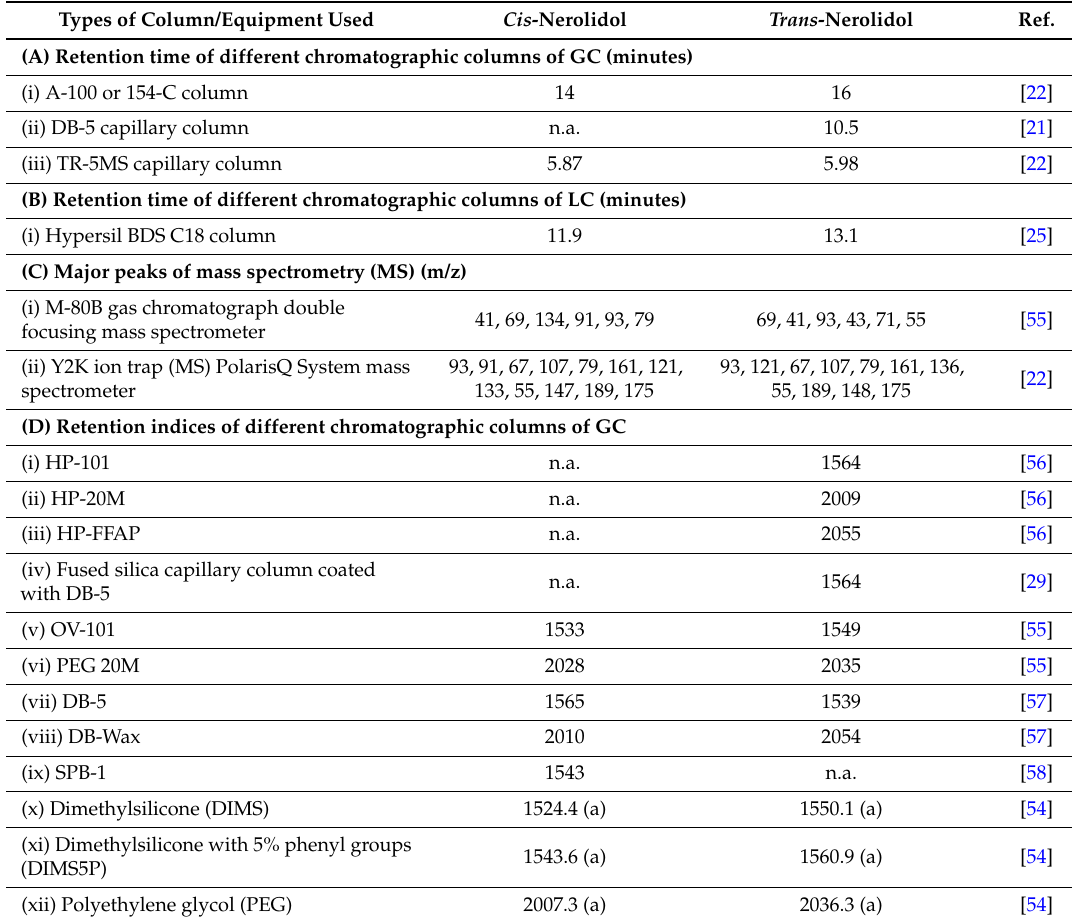
Table 3. Retention indices of different chromatographic columns of GC and major peaks of mass spectrometry to differentiate cis - and trans